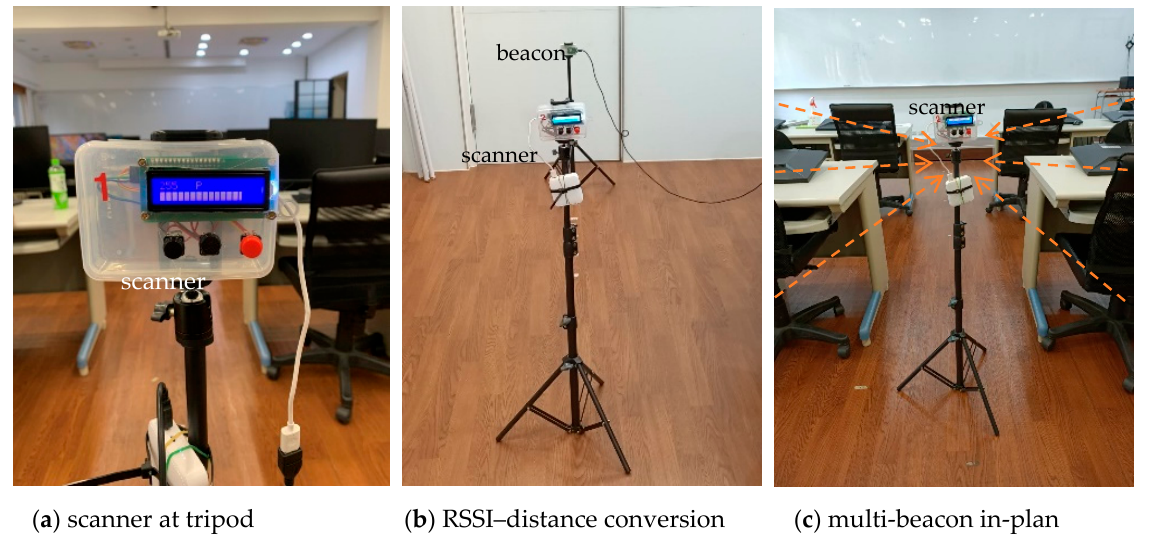
Figure 5. Measurement configurations in the field.